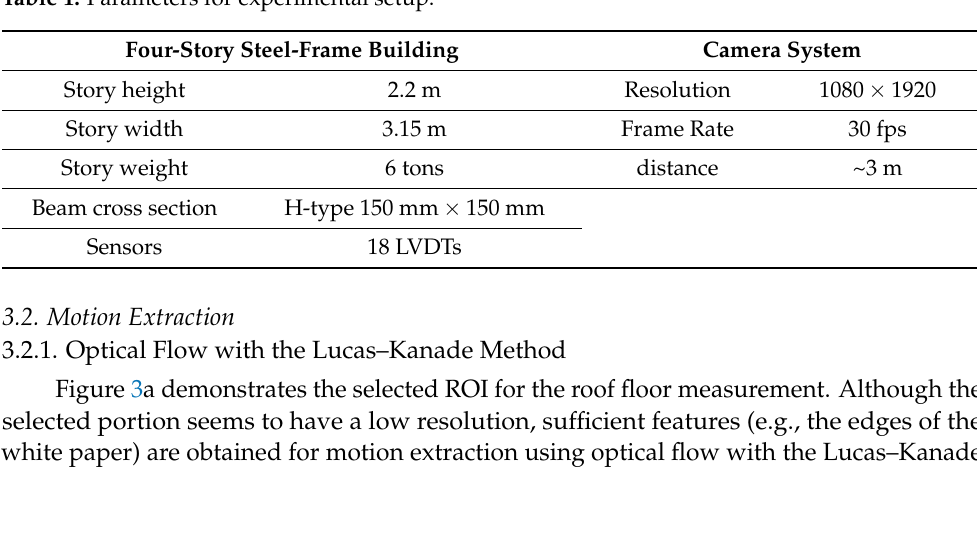
Table 1. Parameters for experimental